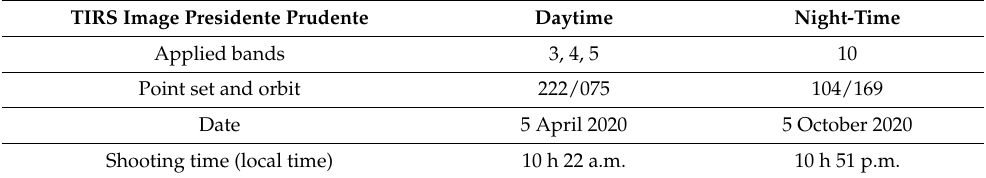
Table 1. Landsat 8 satellite images used in the study applied to Presidente Prudente